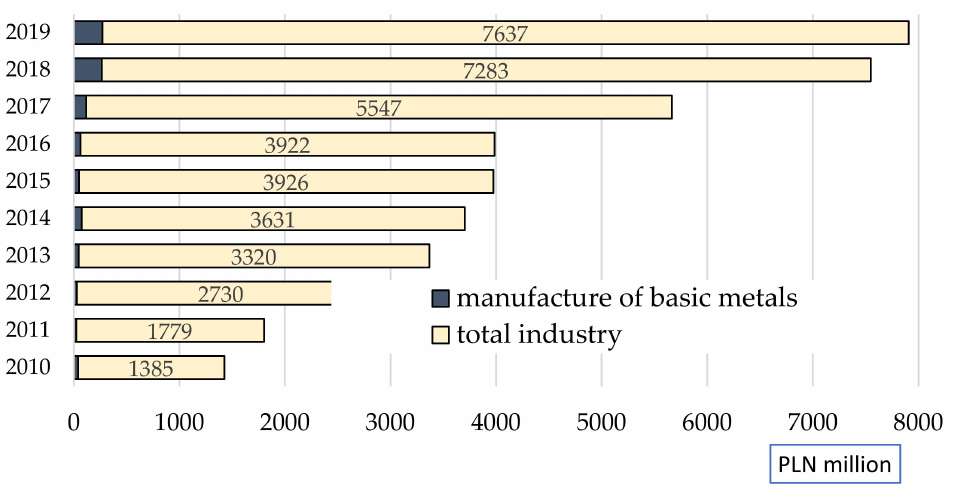
Figure 4. Expenditures on R&D in the manufacture of basic metals and in the total industry in Poland. Source: adapted with permission from Refs.